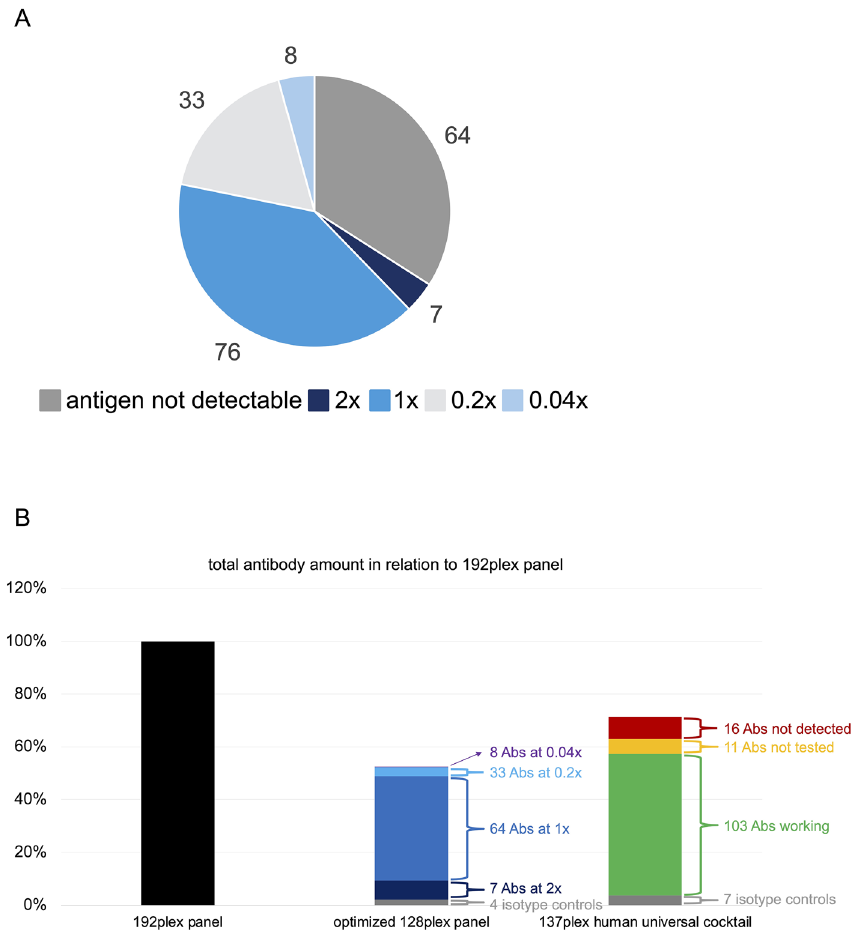
Figure 8. Potential benefits from antibody panel optimization. ( A ) Distribution of optimal antibody concentrations. 64 antibodies showed no signal on PBMCs. The lowest concentration enabling good staining quality was regarded optimal. ( B ) Calculation of the total antibody amount utilized in the optimized 128plex panel (middle) and the commercially available 137plex TotalSeq™ C human universal cocktail (right) in relation to the tested 192plex panel (left). Abs